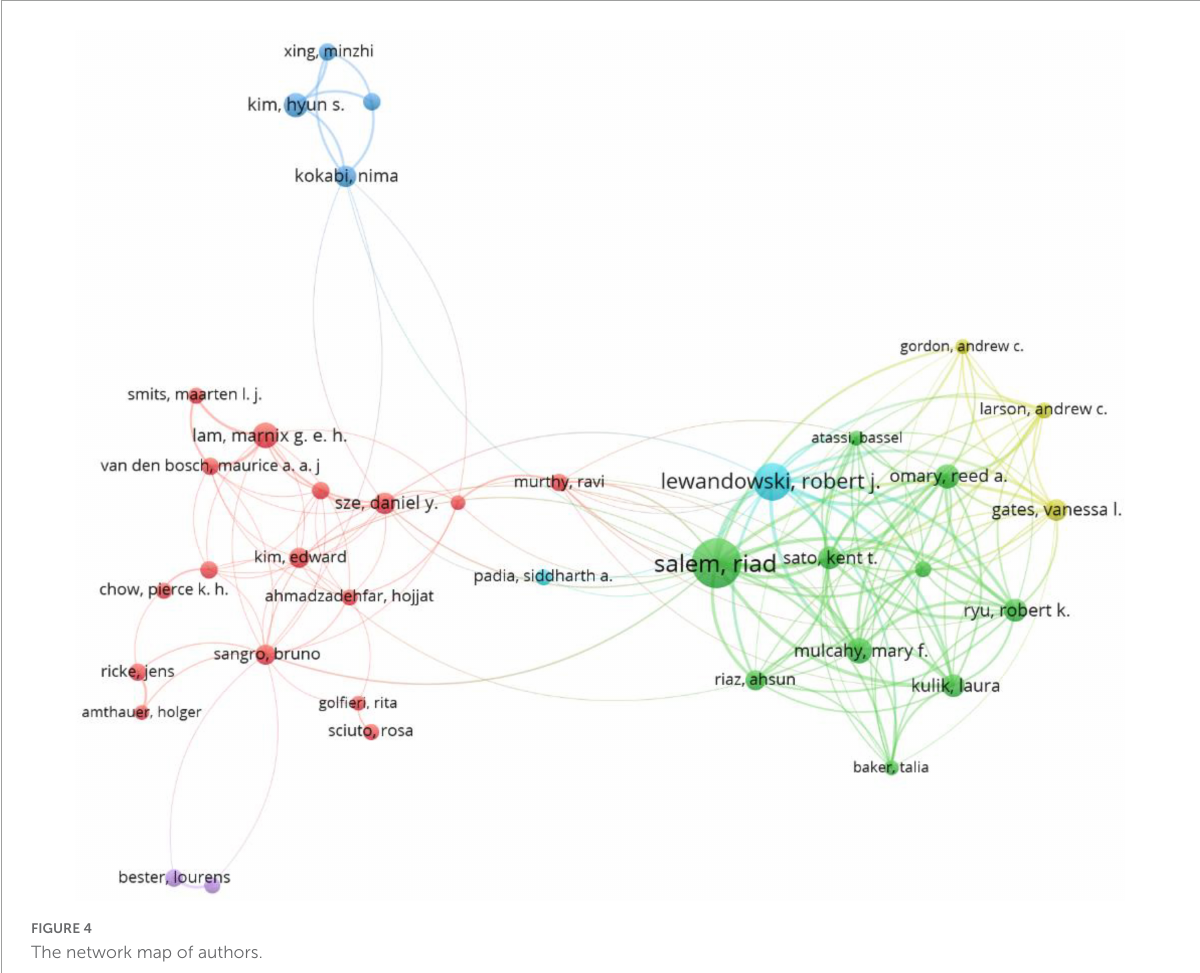
FIGURE4 The network map of authors.